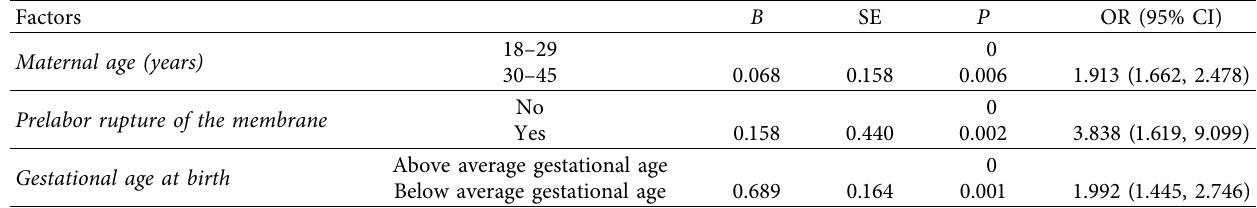
Table 2: Risk factors for GBS colonization in pregnant women: binary logistic regression